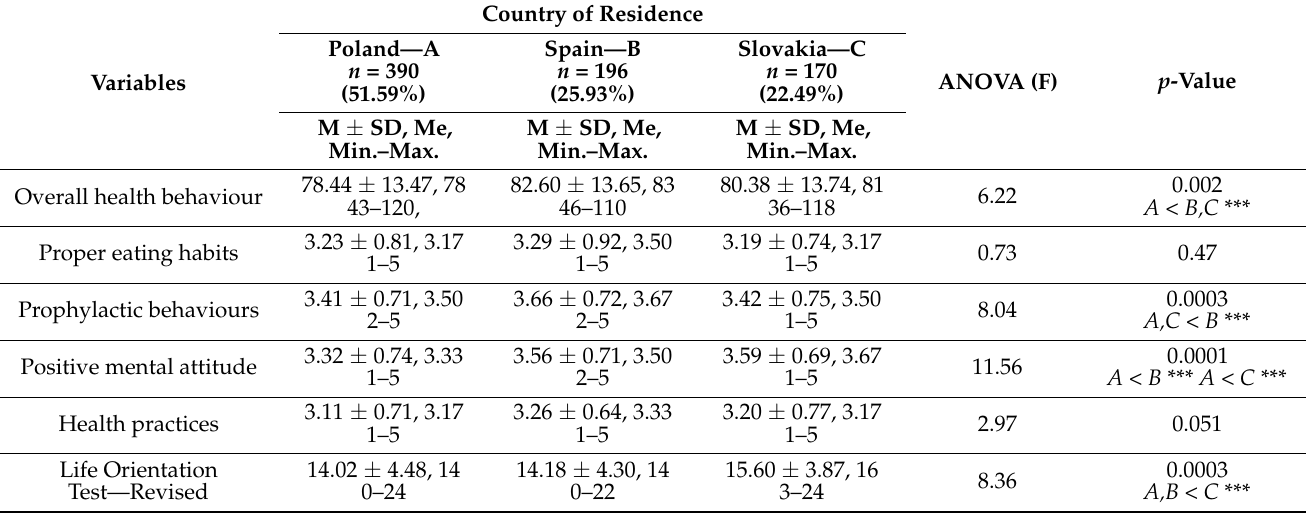
Table 2. Health behaviours vs. intensity of dispositional optimism among the respondents in the study group—results of different significance tests, taking into account the grouping variable country of residence.